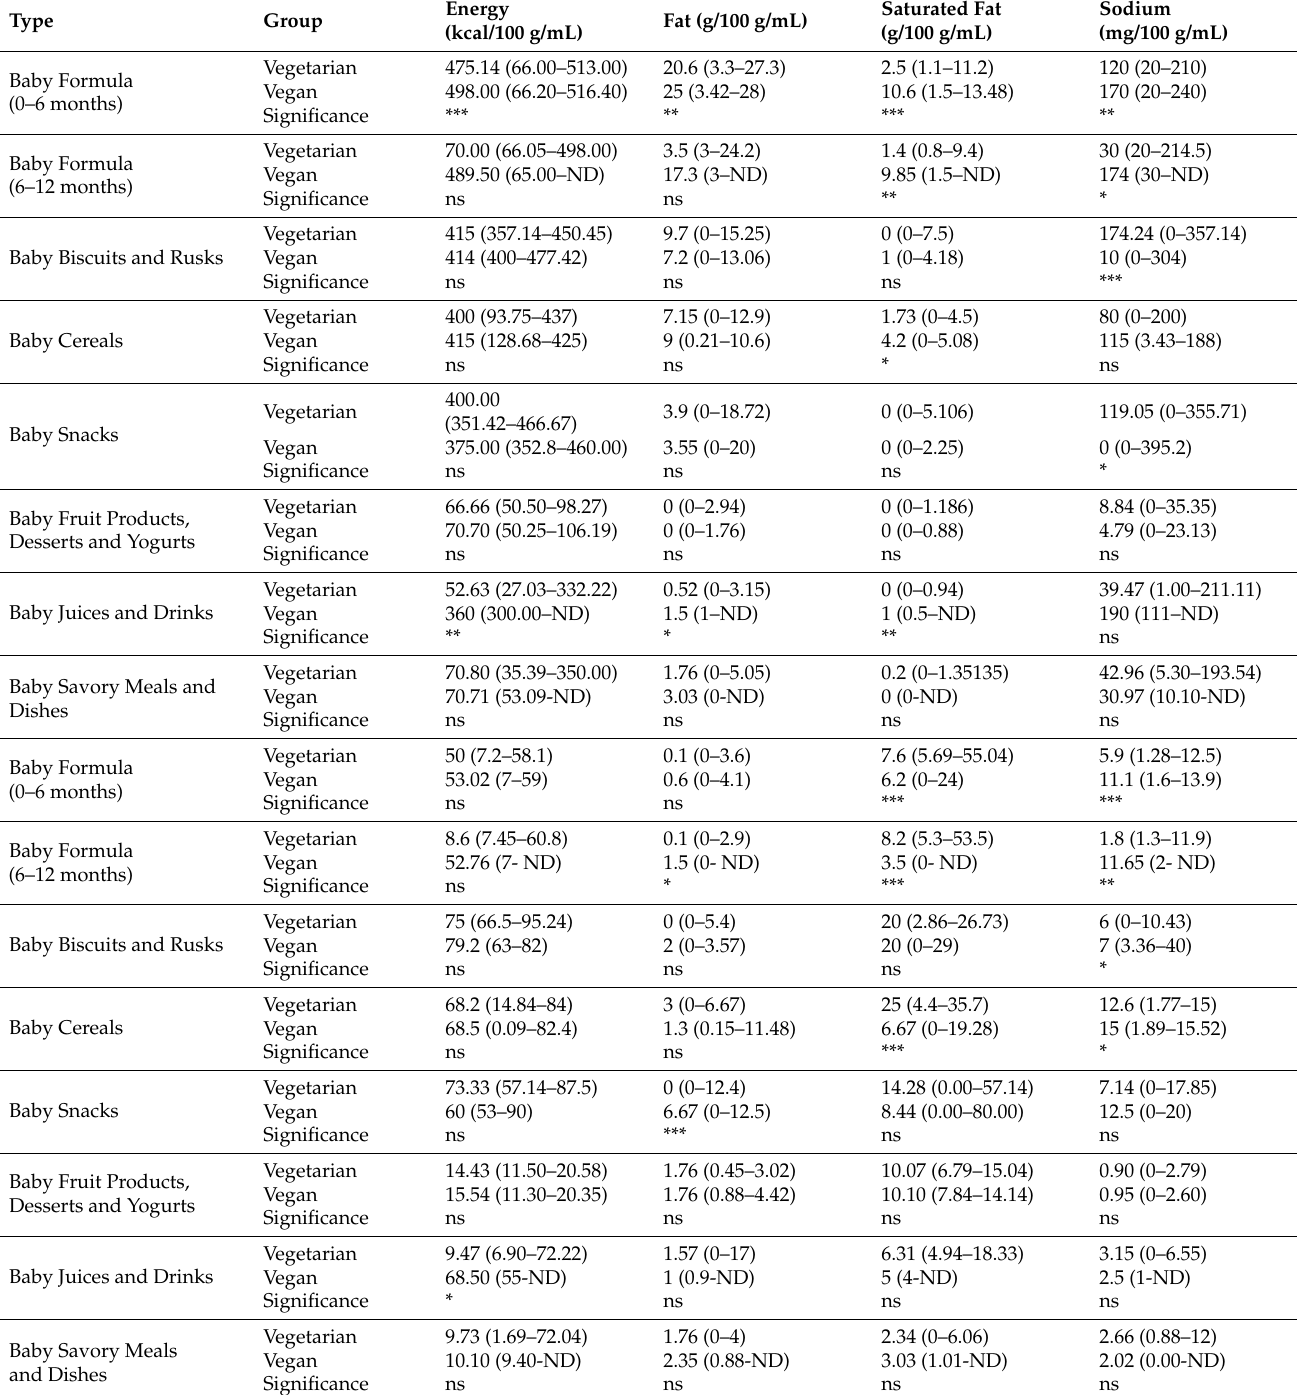
Table 2. Nutritional facts of commercial infant